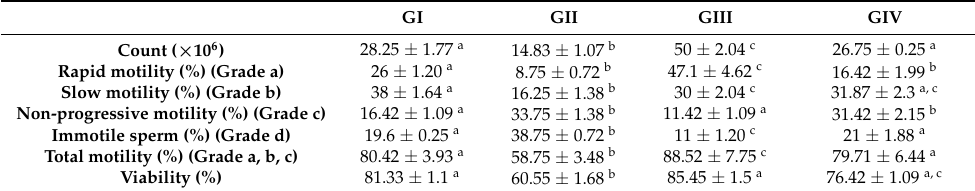
Table 1. Effect of acrylamide and/or earthworm extract on sperm count, motility, and viability. GI GII